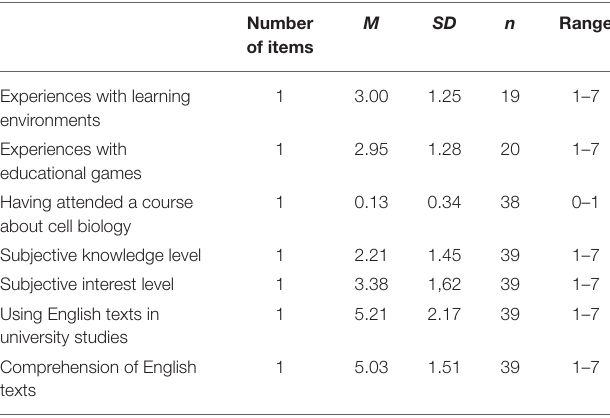
M SD n Number of items